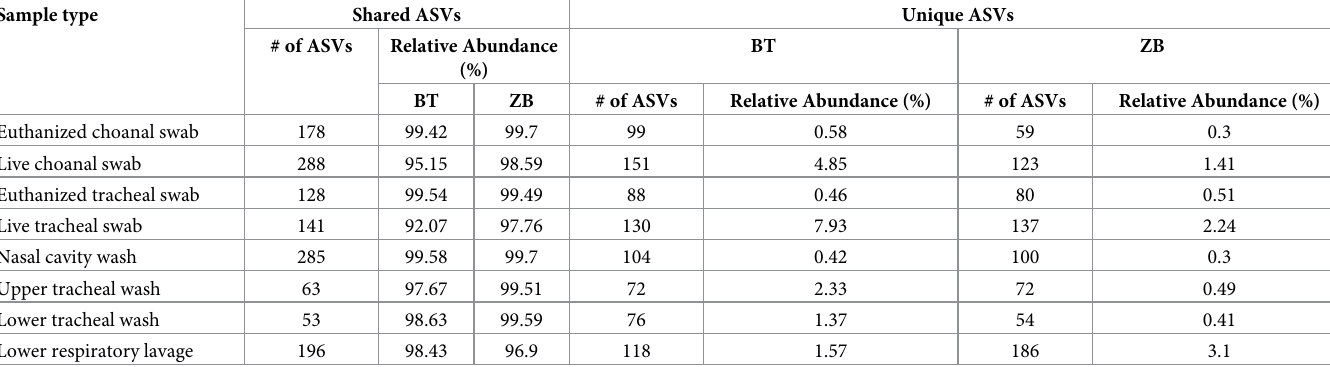
Table 3. Comparison of the number of shared and unique ASVs and their relative abundance between the kits.